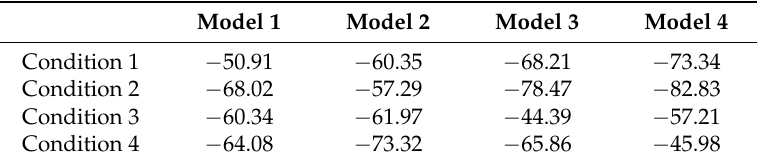
Table 4. Average Log likelihood outputted by